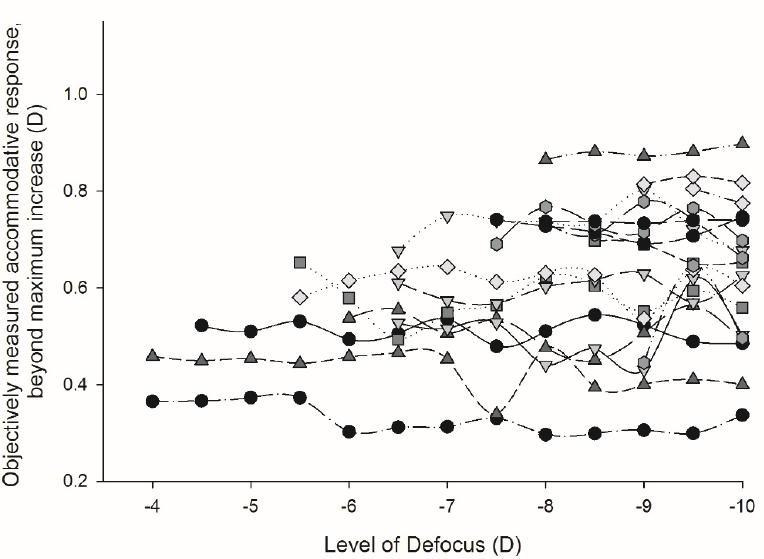
Figure 7. Objectively measured accommodative response, beyond maximum accommodation stimulation. The objectively measured accommodative response, once maximum accommodation had been stimulated for participants whose objective accommodative range was ≤ 9.5 D. n = 19, each symbol represents a participant’s response.